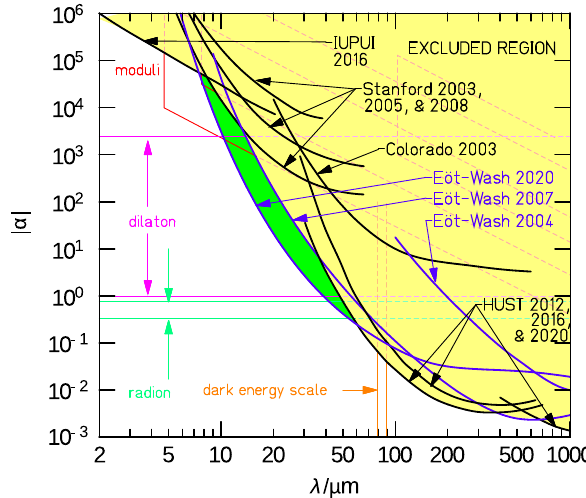
Fig. 3 Present 95% CL exclusion contours (in yellow) from several experiments on Yukawa-like deviations from Newton’s 1 / r 2 law in the (λ, | α | ) plane (from Refs. [16–24]). In green, the region excluded by the recent analysis in Ref. [25]. The figure is adapted from this last